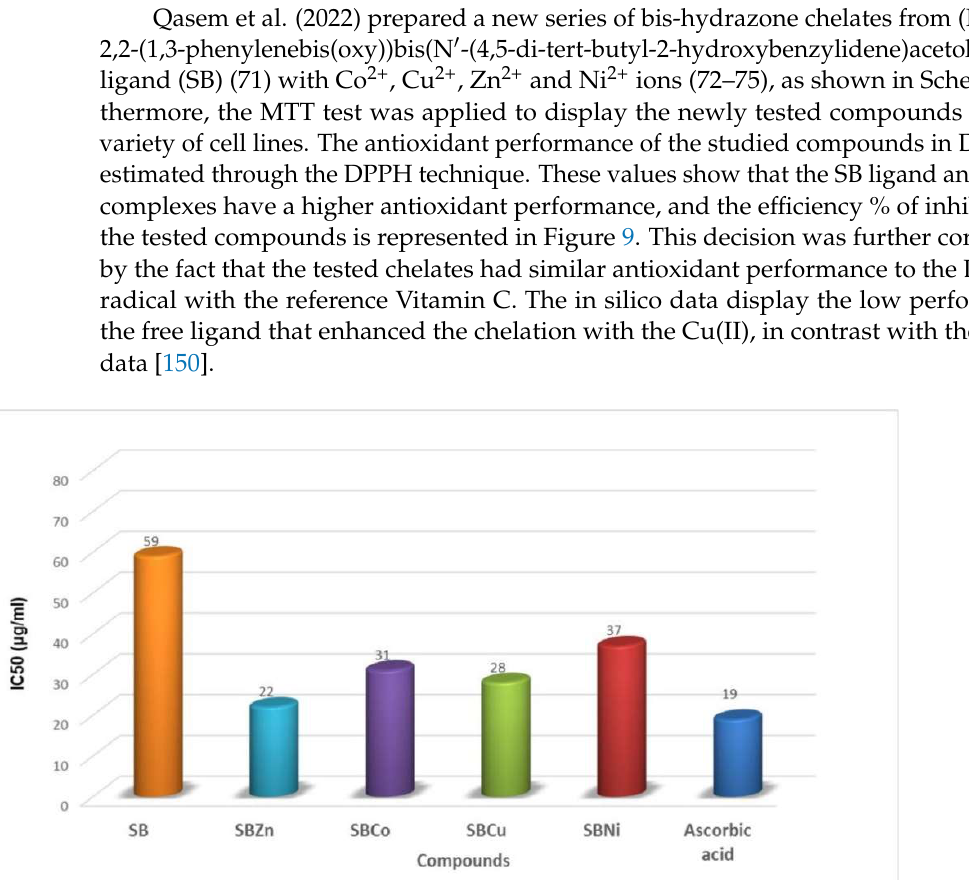
Figure 9. The suppression of the DPPH radical for tested compounds. Reproduced from the permission of ref. [150]. data display the low performance of the free ligand that enhanced the chelation with the Cu(II), in contrast with the practical data